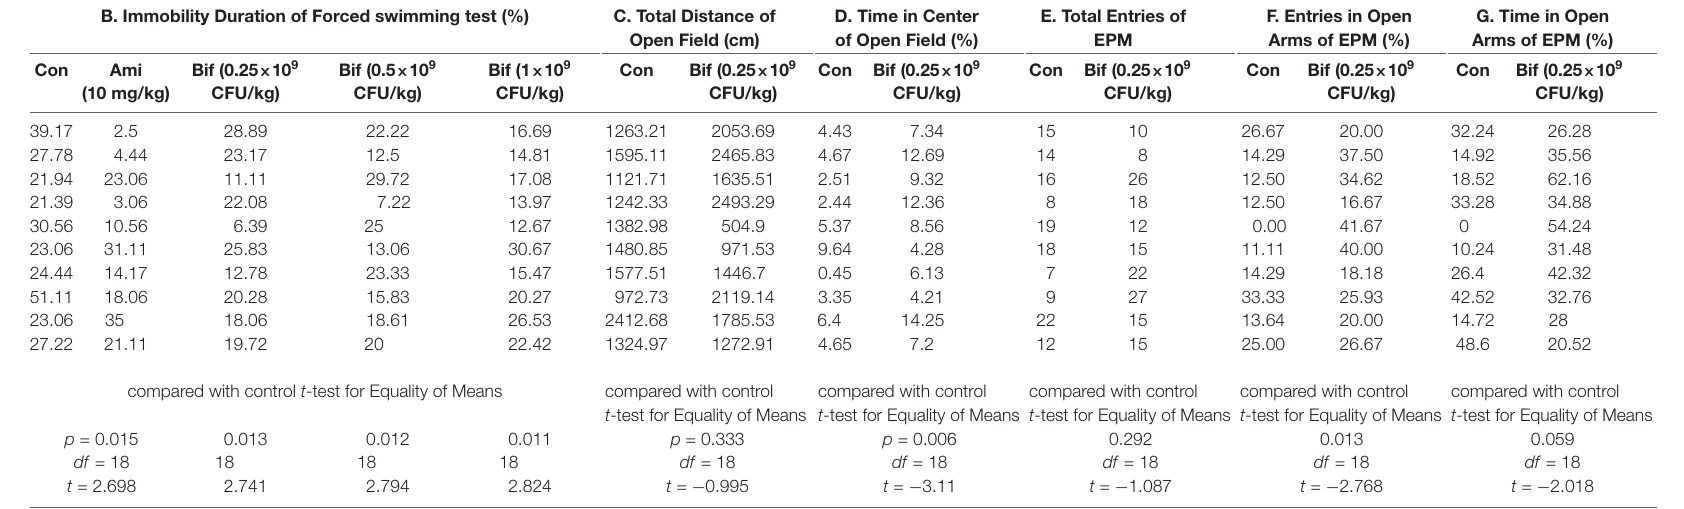
TABLE 1 | Potential anxiolytic and antidepressant effects of B. adolescentis .